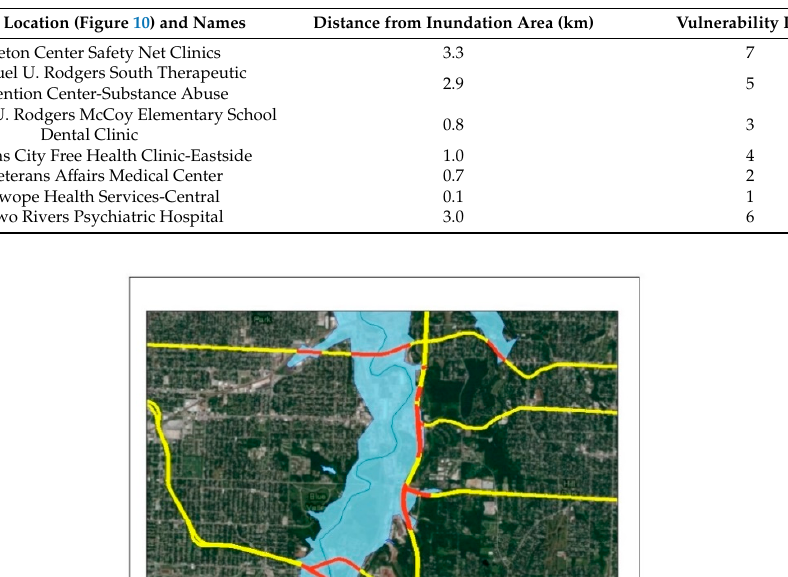
Table 6. List of hospitals vulnerable to the flood of May 2017 in Kansas City, Missouri.